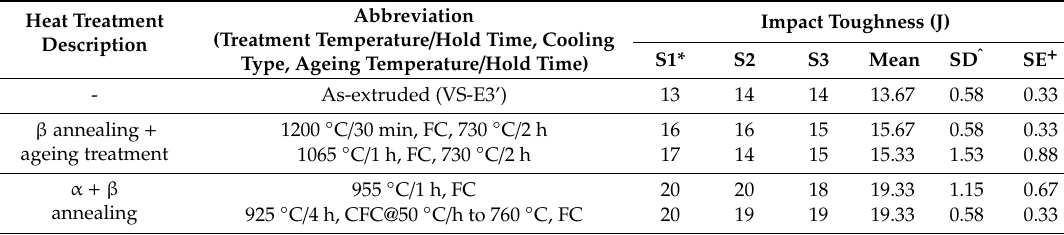
Table 3. Impact toughness of heat-treated Ti-6Al-4V alloy rods produced by powder compact extrusion (PCE).